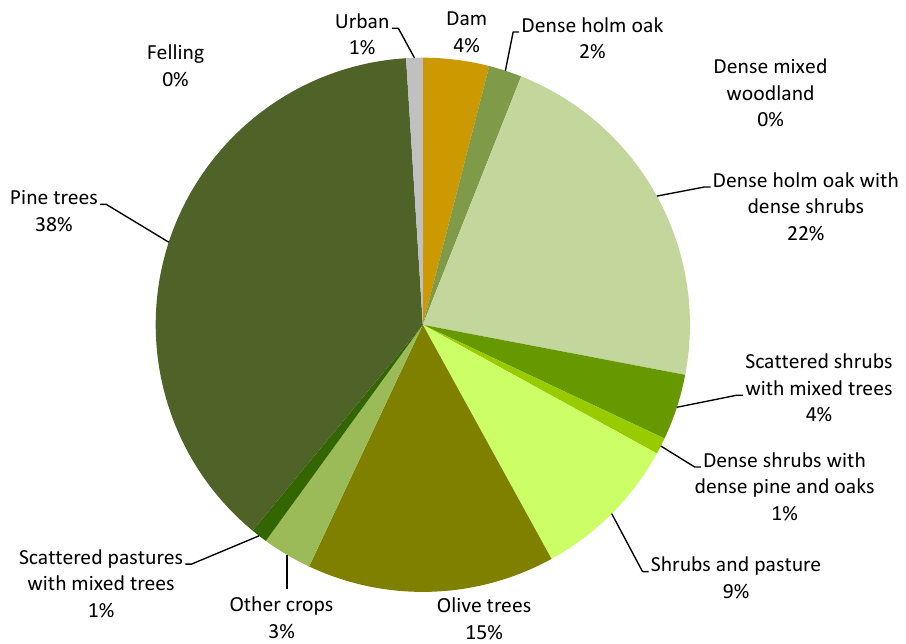
Figure 6: Coverages that have substituted the spaces catalogued as dehesa in